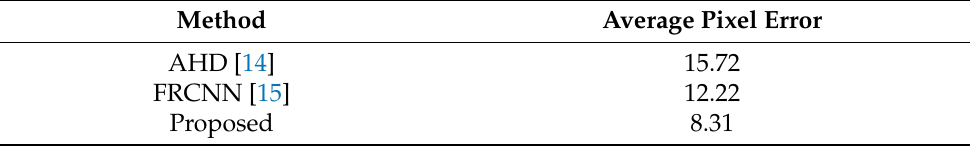
Table 2. Comparison on the EgoFinger